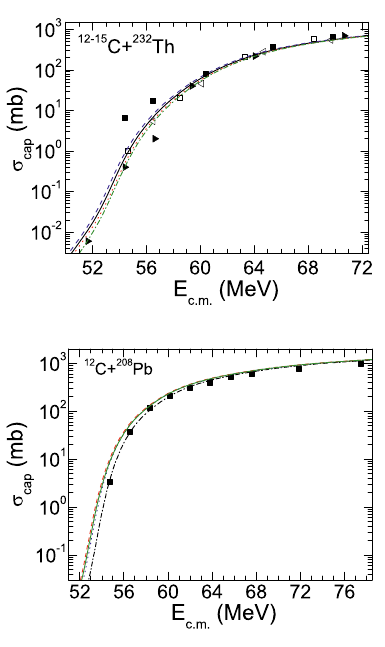
Figure 12. (Color online) The calculated (lines) and experimental (symbols) capture cross sections vs E c . m . for the reactions 12 C + 232 Th (dash-dotted line, solid triangles), 13 C + 232 Th (dotted line, open triangles), 14 C + 232 Th (solid line, open squares), and 15 C + 232 Th (dashed line, solid squares). The experimental data are from Refs. [24, 25].